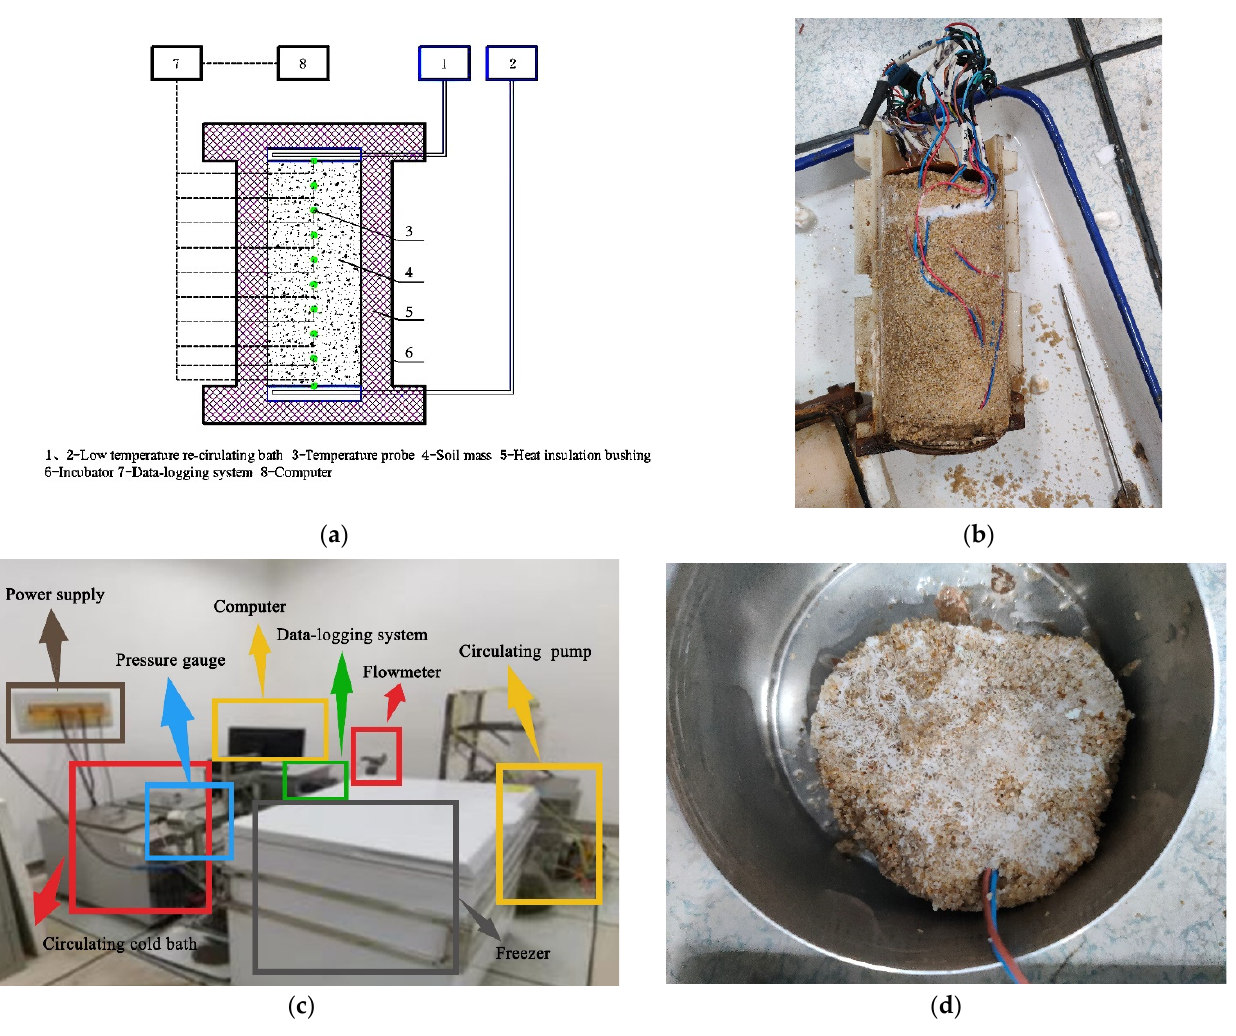
Figure 1. Experimental correlation diagram. ( a ) Principle of an experiment; ( b ) soil preparation and probe layout; ( c ) laboratory equipment; ( d ) frozen soil at the end of the experiment.